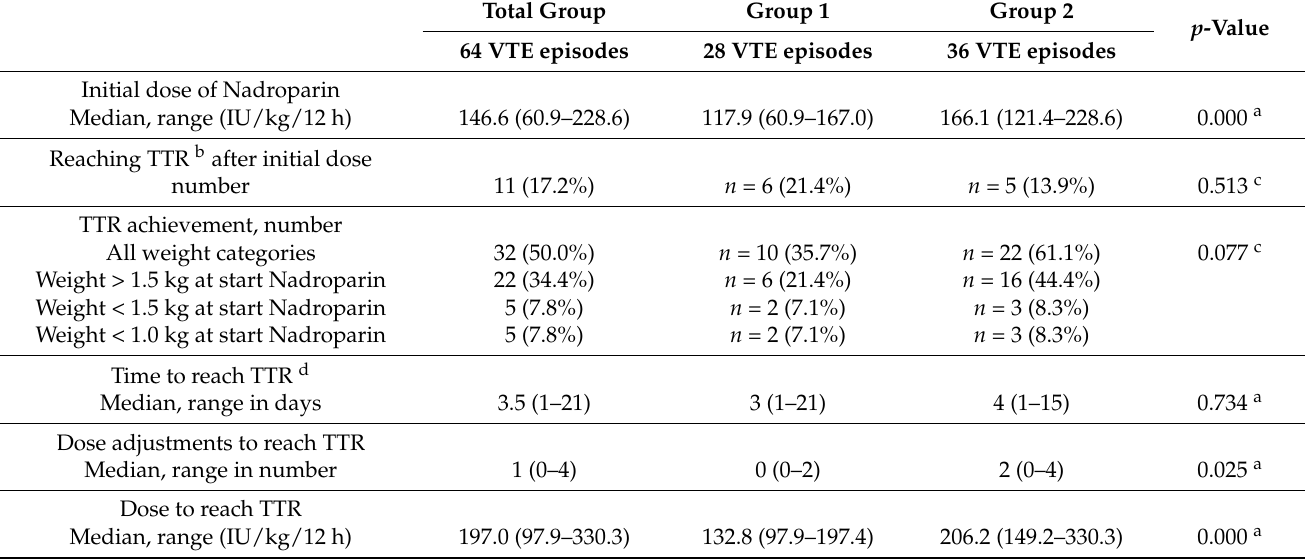
Table 2. Therapeutic target